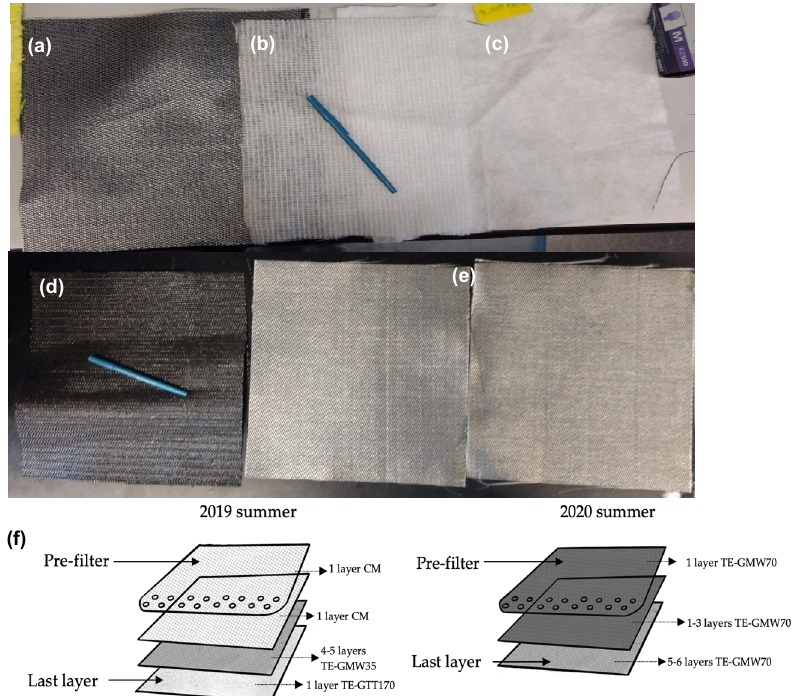
Figure 5. Geotextiles and mesh used in the experiment: ( a ) woven geotextile TE-GMW35—AOS: 425 µm ( b ) CM and ( c ) non-woven geotextile TE-GTT170—AOS: 350 µm before the filtration process ( b ) woven geotextiles used in the deployment: ( d ) TE-GMW70—AOS: 700 µm and ( e ) TE-GMW35—AOS: 425 µm before the filtration process ( f ) Scheme representing the number and order of geotextile layers used in the deployments.